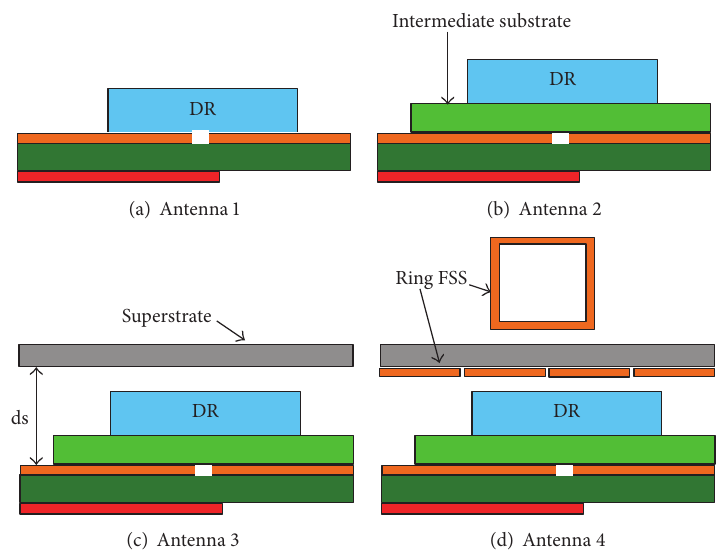
Figure 28: Millimeter-wave DRA topologies presented in [64].